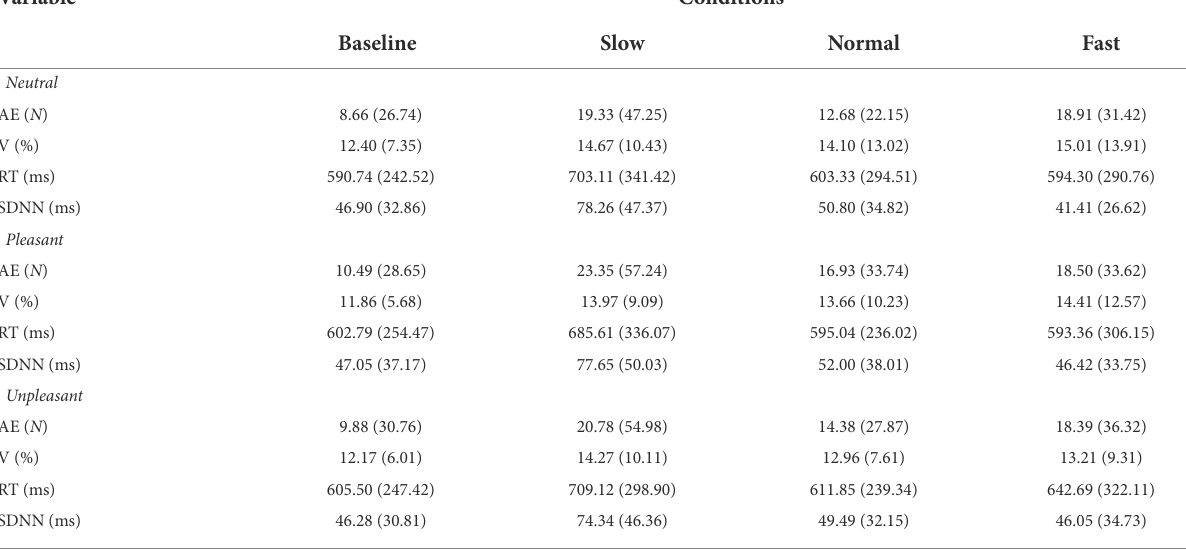
TABLE 3 M ( SD ) values for breathing conditions while viewing neutral, pleasant, and unpleasant